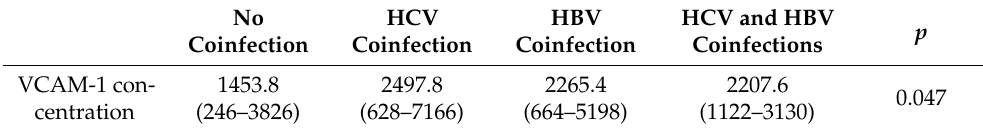
Table 4. The results of the ANOVA test assessing coinfections and VCAM-1 concentration.